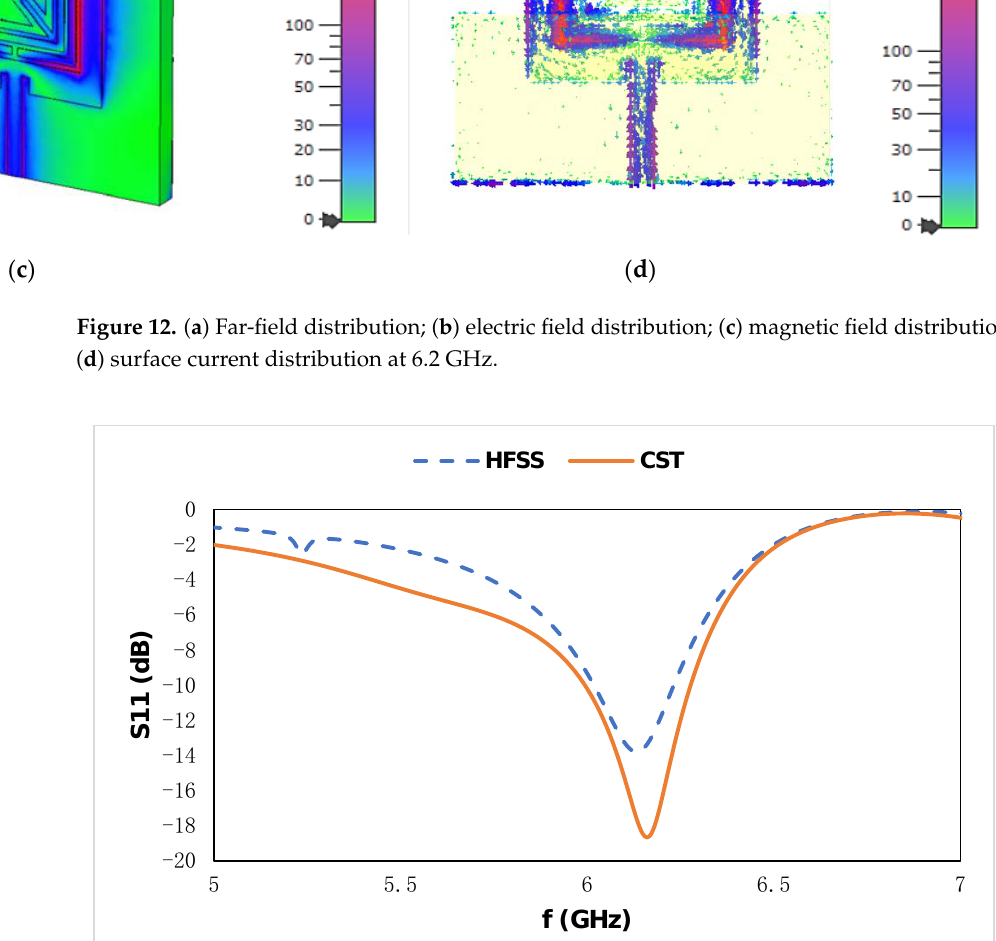
Figure 13. Reflection coefficient of the proposed sensor in CST and HFSS.